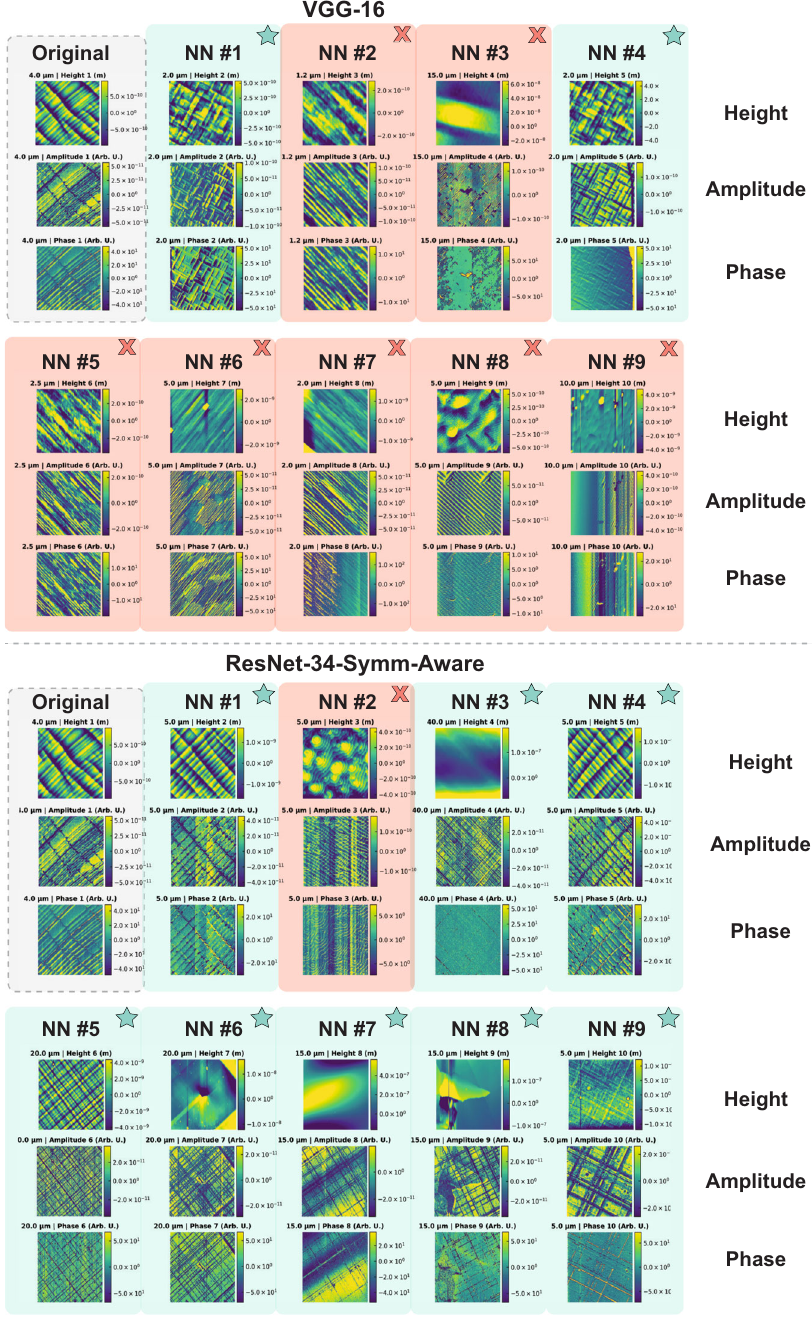
Fig. 4 Comparison to UMAP-projections using natural image and symmetry-aware features. Nine (9) next-nearest neighbors in UMAP- projected space near a random piezoresponse force microscopy image for the ( a ) VGG-16, and ( b ) ResNet-34-Symm-Aware model. The images determined to be semantically similar are marked with a green-star, and those deemed different are marked with a red x. These images were extracted by fi nding the nearest neighbors in Euclidian space from a selected image in the UMAP projection. The selected image is marked original. The nearest neighbors are sorted by increasing Euclidean distance from the original randomly selected